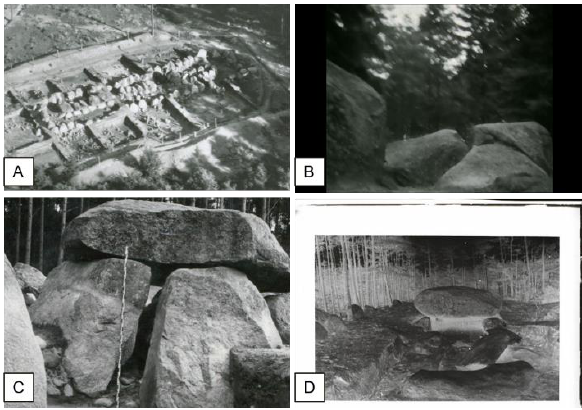
Figure 2: Historical aerial image (a), historical film record (b), historical photograph (c), historical glass plate negative (d)